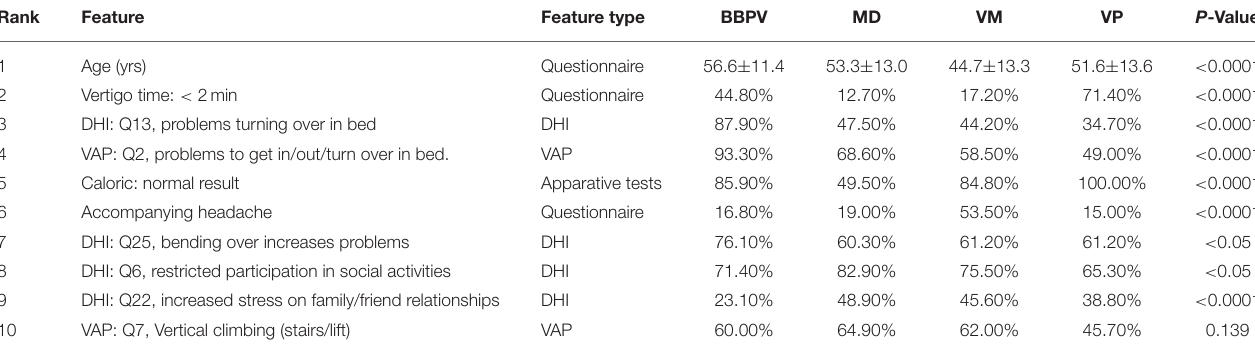
TABLE 4 | Top 10 most important features in Task 3, aggregated over multiple classifiers.